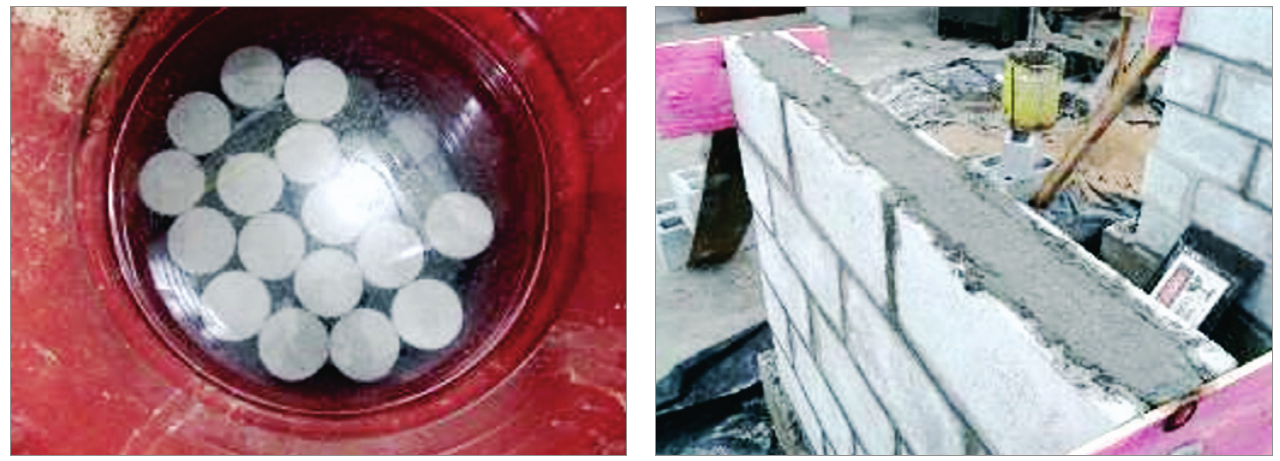
Figura 4 Moldagem dos corpos-de-prova cilindricos de graute e grauteamento das paredes